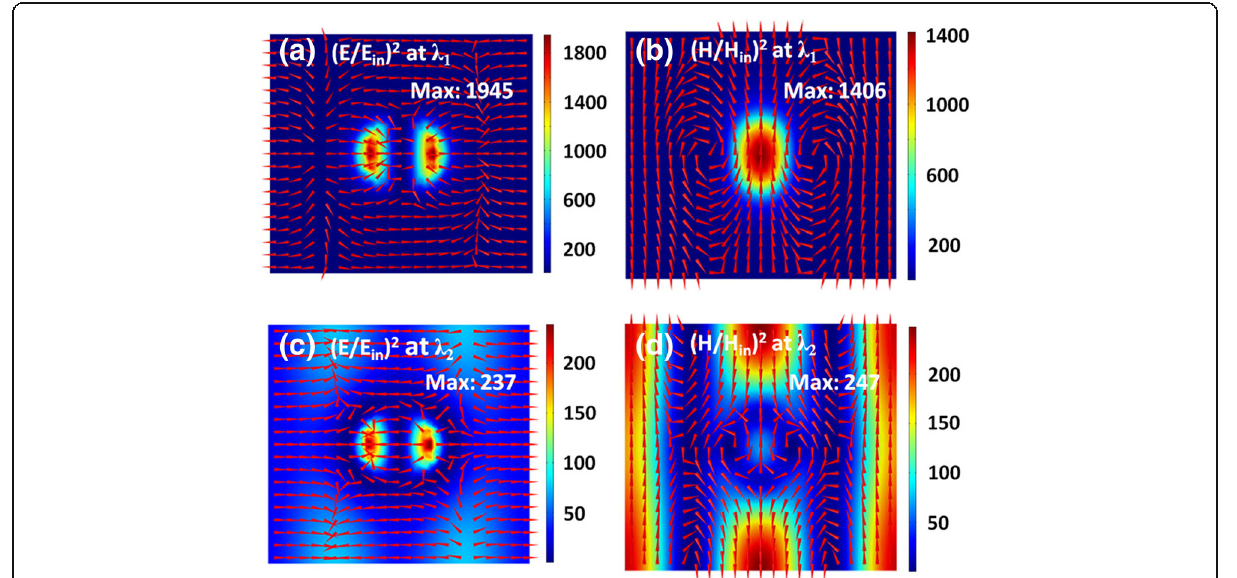
Fig. 4 a – d Normalized electric field intensity ( E / E in ) 2 and magnetic field intensity ( H / H in ) 2 on the xoz plane across the center of the SiO 2 spacers at the resonance wavelengths of λ 1 and λ 2 labeled in Fig. 3. Red arrows represent the field direction, and colors show the field strength